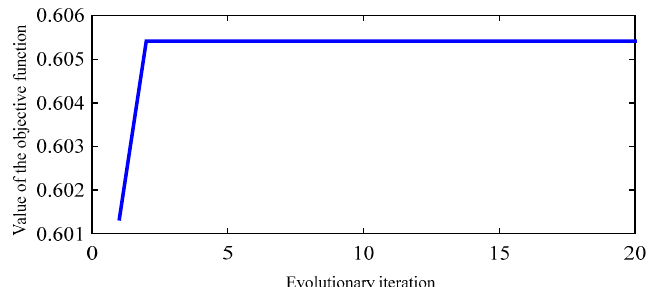
Figure 34. Variation curve of between the objective function and the number of evolutionary iterations for the challenging signal. Table 3. Efficacy coefficients corresponding to Decomposed Mode components to the challenging signal.